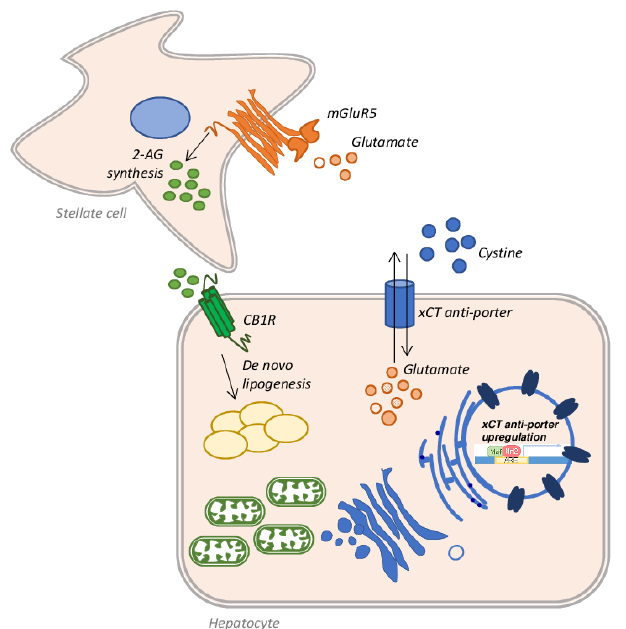
Figure 7. Schematic representation of the cross-talk between hepatocytes and stellate cells in alcoholic liver disease (ALD). Nrf2 activation leads to the upregulation of the xCT anti-porter system, which introduces cysteine within the hepatocytes and favors the efflux of glutamate in the extracellular space. Glutamate binds its mGluR5 receptor on the stellate cell surface, which synthetizes and releases 2-AG. 2-AG, once bound to its receptor CB1R, promotes the de novo lipogenesis mechanism activation and consequent lipid accumulation in the hepatic cells.